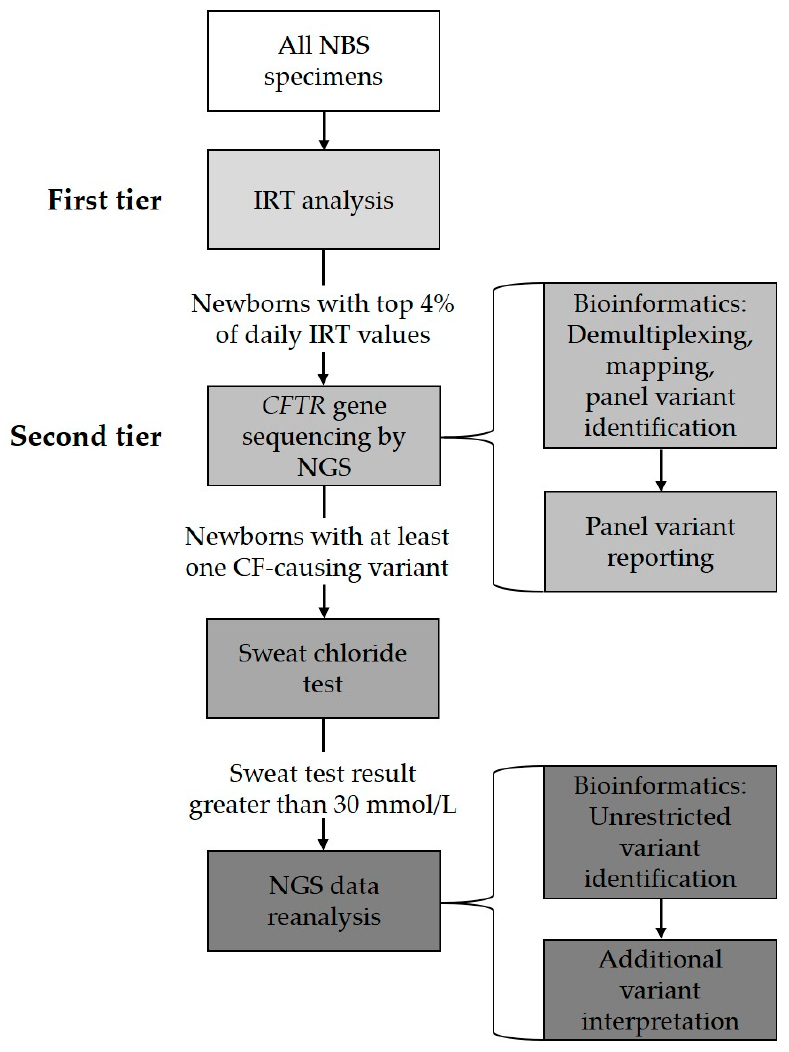
Figure 1. Wisconsin NBS for cystic fibrosis workflow.